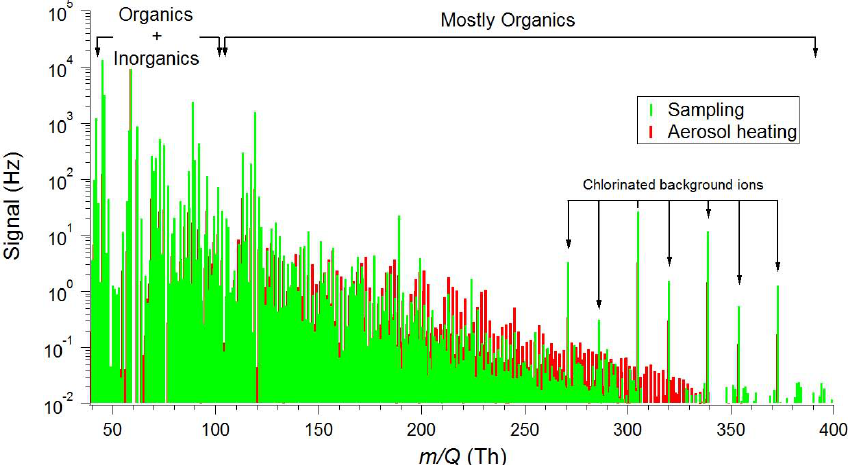
Fig. 2. Mass spectrum showing organic acids measured during the sampling and aerosol heating steps. Signal shown here is background- corrected, and is scaled appropriately for the higher sampling rate of the